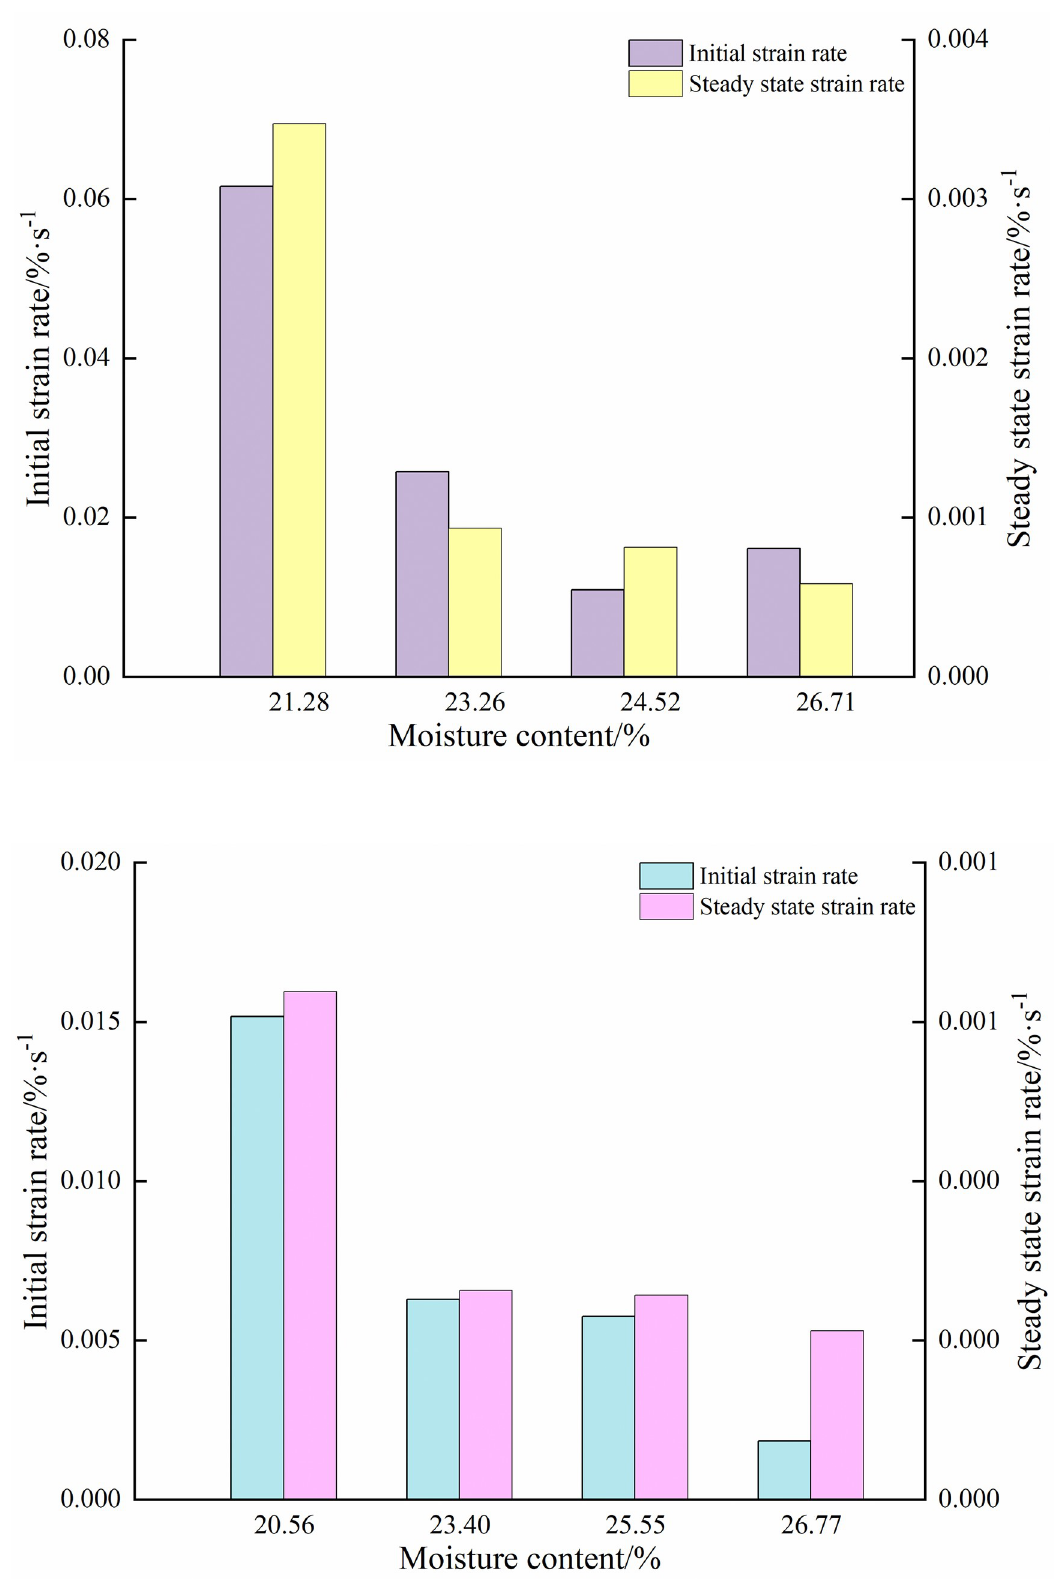
Fig 9. The creep rate of each treatment in the initial and steady-state stages. (a) No tillage; (b) Plough tillage. https://doi.org/10.1371/journal.pone.0253623.g009 PLOS ONE | https://doi.org/10.1371/journal.pone.0253623 June 24,